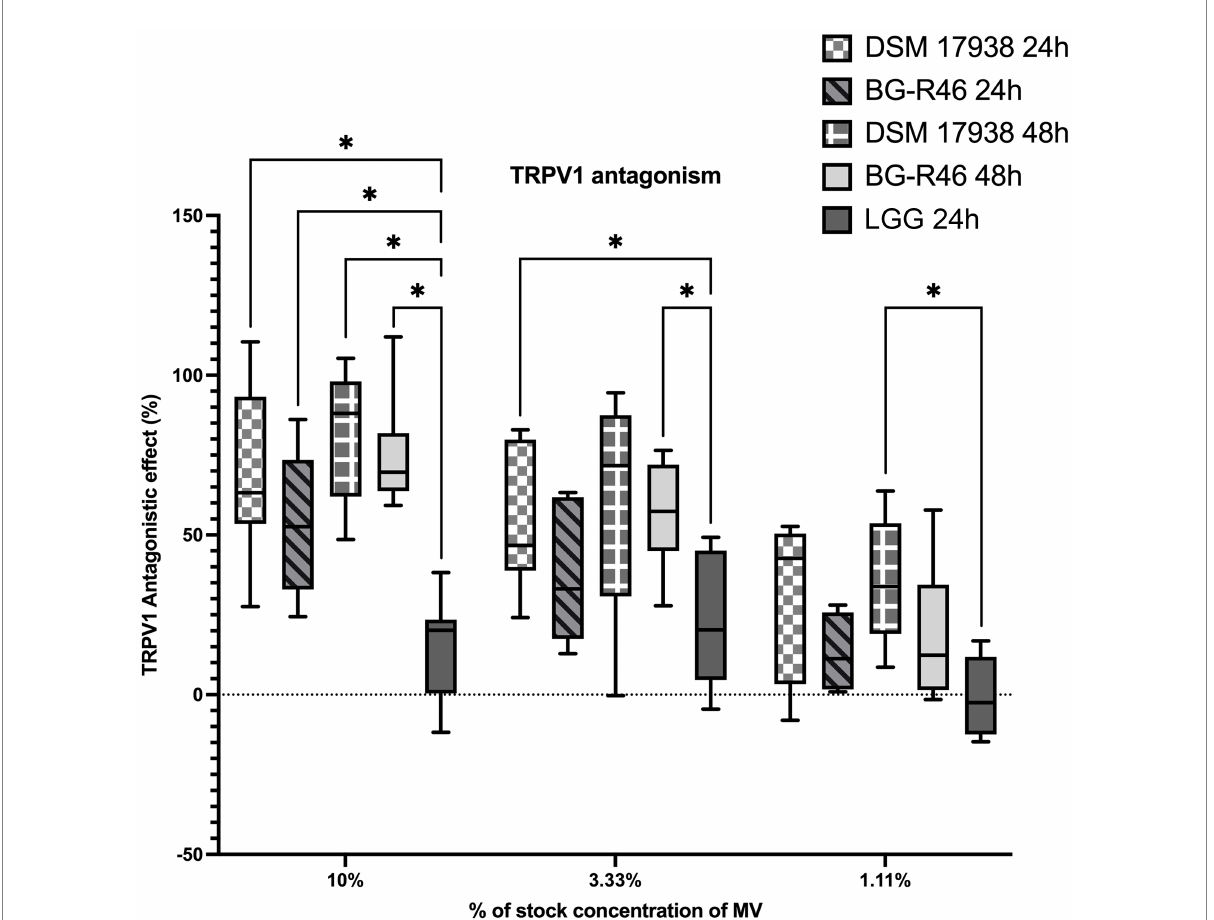
FIGURE 8 TRPV1 antagonistic effect of extracellular membrane vesicles in primary rat dorsal root ganglion cells (rDRGs). Primary rDRGs were incubated with membrane vesicles in three different concentrations (10%, 3.33%, 1.11%) for 1 h before the experiment. Capsaicin was added and Ca 2+ was measured and antagonistic response was calculated. Data show that L. reuteri DSM 17938 and BG-R46 derived MV antagonize TRPV1 in a dose dependent manner. Box plot with min to max and average value representation. DSM 17938 24 h denote MV from L. reuteri DSM 17938 24 h; DSM 17938 48 h denote MV from L. reuteri DSM 17938 48 h; BG-R46 24 h denotes MV from L. reuteri BG-R46 harvested at 24 h; BG-R46 48 h denotes MV from L. reuteri BG-R46 harvested at 48 h. Box plot with min to max and average value representation. N = 9 for DSM 17938, DSM 17938, BG- R46 48 h. N = 6 for BG-R46 24 h. Asterix * indicates p <